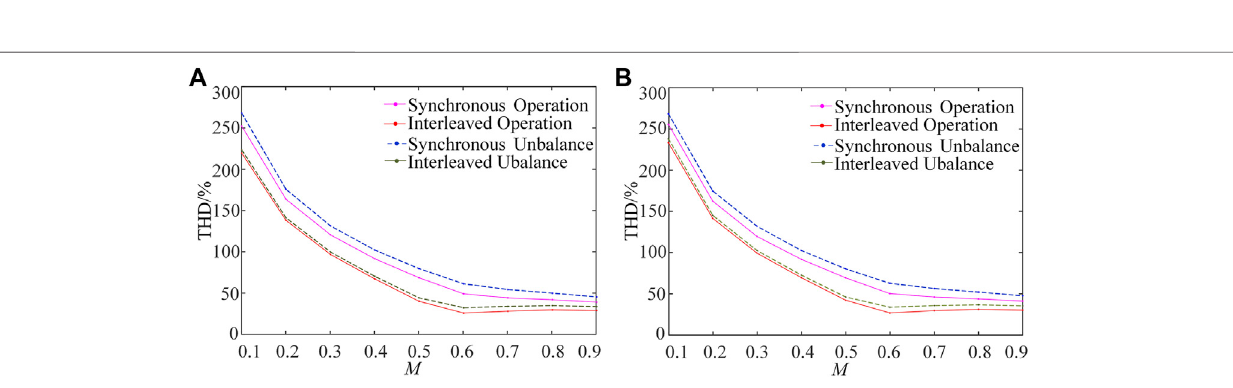
FIGURE 12 | Results of line-to-line voltage THD for different modulation ratios: (A) simulation, (B) experiment.